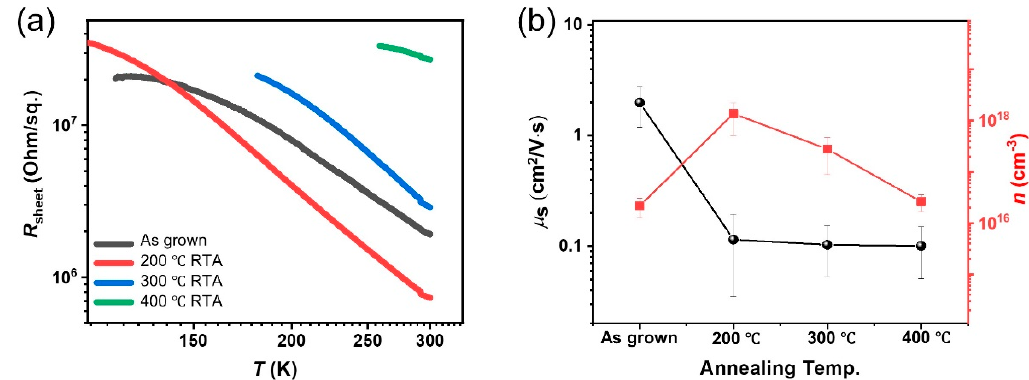
Figure 5. ( a ) Temperature dependent sheet resistance and ( b ) Hall mobility and carrier concentrations at 300 K for four nanowall samples (as grown and RTA at 200 °C, 300 °C, and 400 °C for 10 min).